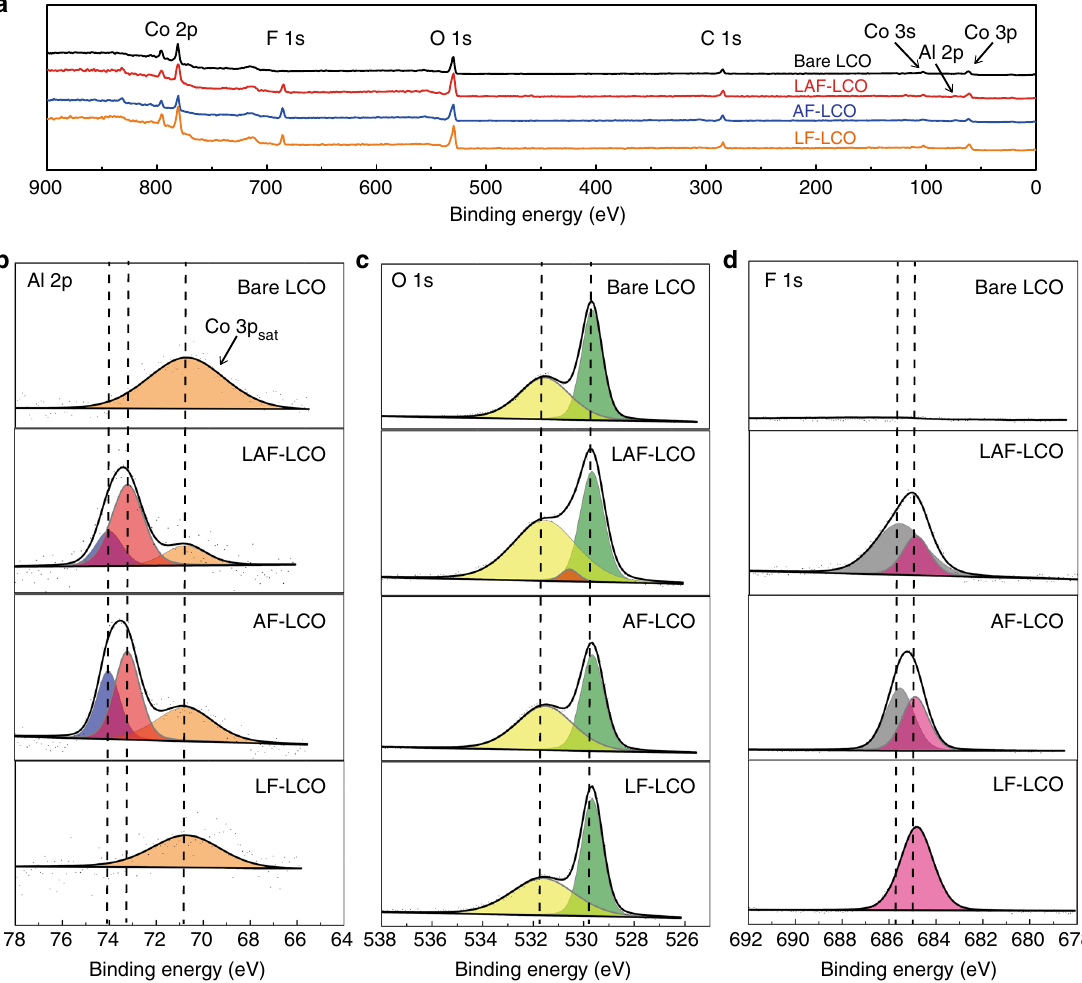
Fig. 3 Characterization of XPS. a XPS patterns of bare LCO and 2% LAF/AF/LF-LCO. b – d Fine XPS scans of Al 2p peaks (including Co 3p sat peak), O 1s peaks, and F 1s peaks, respectively. Source data are provided as a Source Data fi